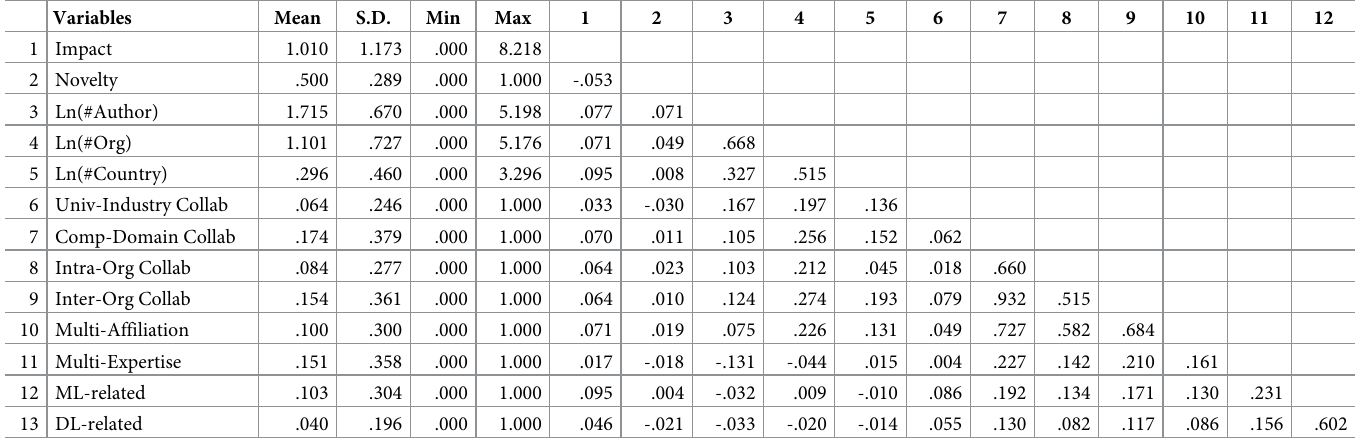
Table 1. Descriptive statistics and correlation